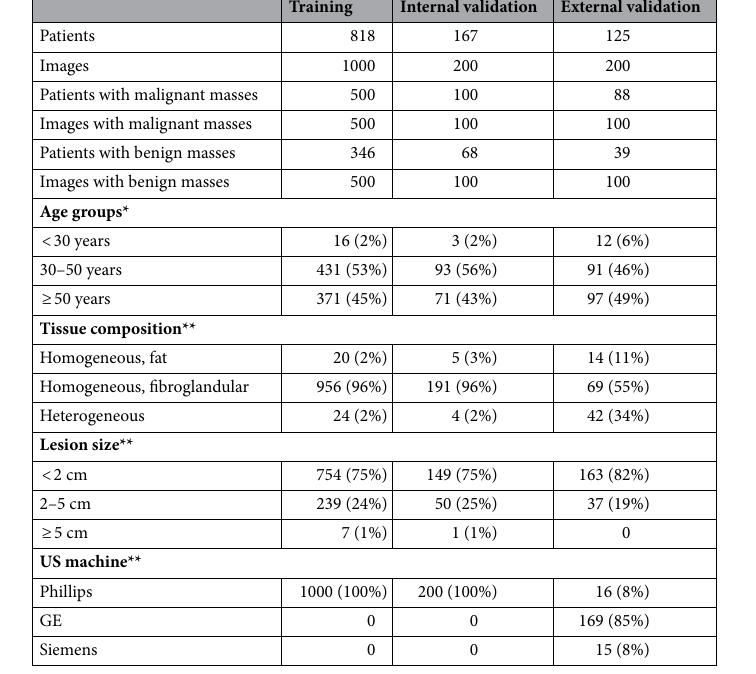
Table 1. Baseline characteristics of datasets. *Patient-level, **image-level.